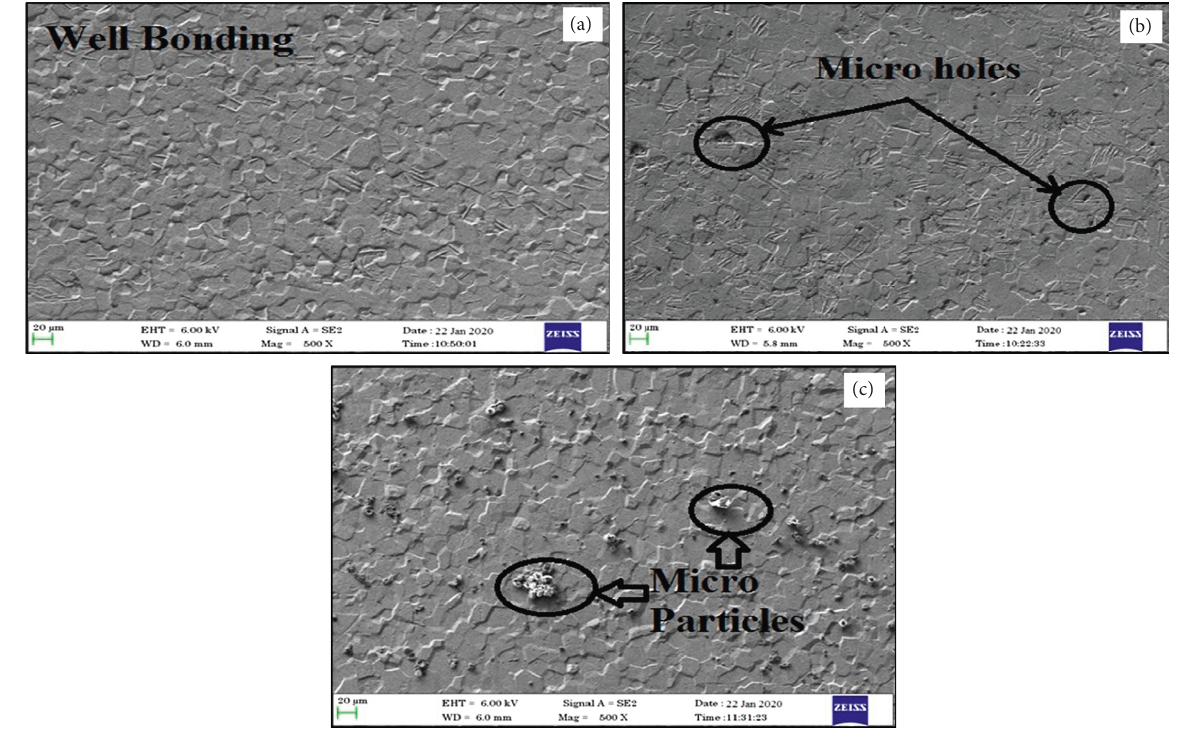
Figure 6: SEM image of samples after (a) 1000rpm, (b) 1200rpm, and (c)